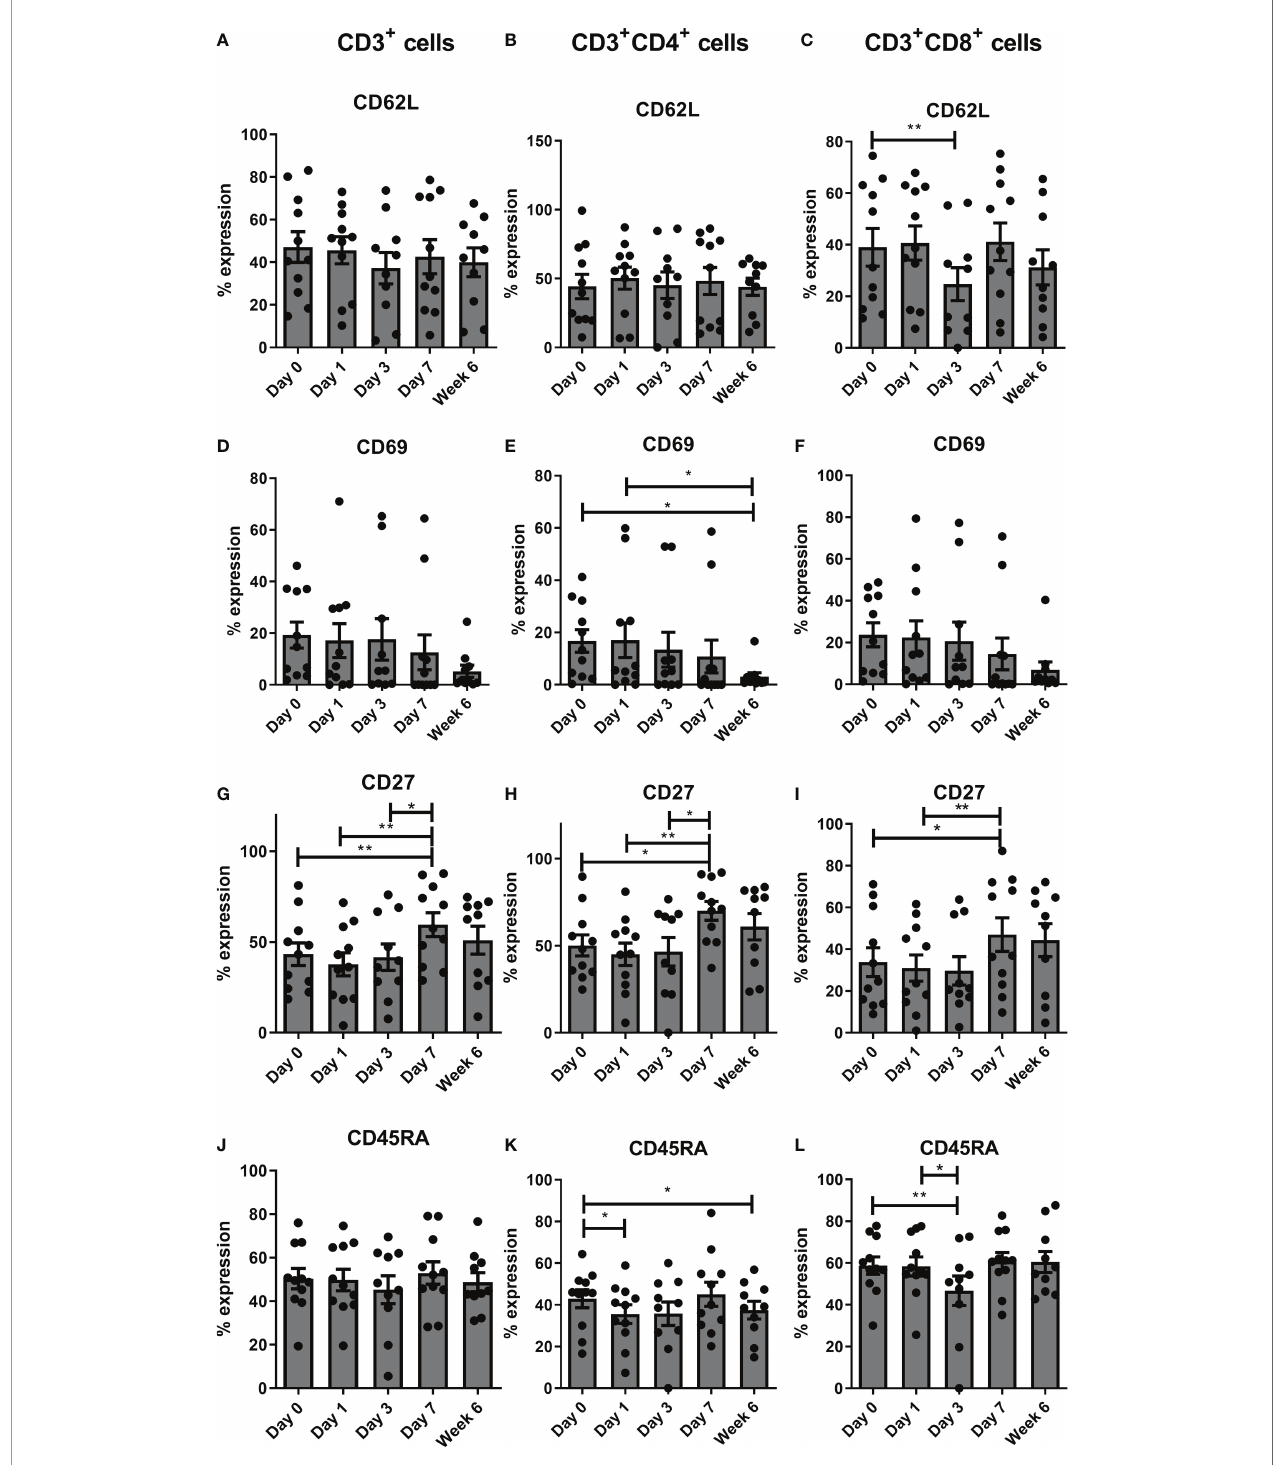
FIGURE 2 | Frequencies of circulating CD27 + T cells increase sequentially in the immediate post-operative period. Expression of the following T cell activation markers CD62L (A – C) , CD69 (D – F) , CD27 (G – I) and CD45RA (J – L) were assessed on circulating CD3 + , CD3 + CD4 + and CD3 + CD8 + cells by fl ow cytometry in OAC patients on POD 0, 1, 3, 7 and 6 weeks post-surgery 6 (n=11). Paired, non-parametric t-test *p<0.05 and